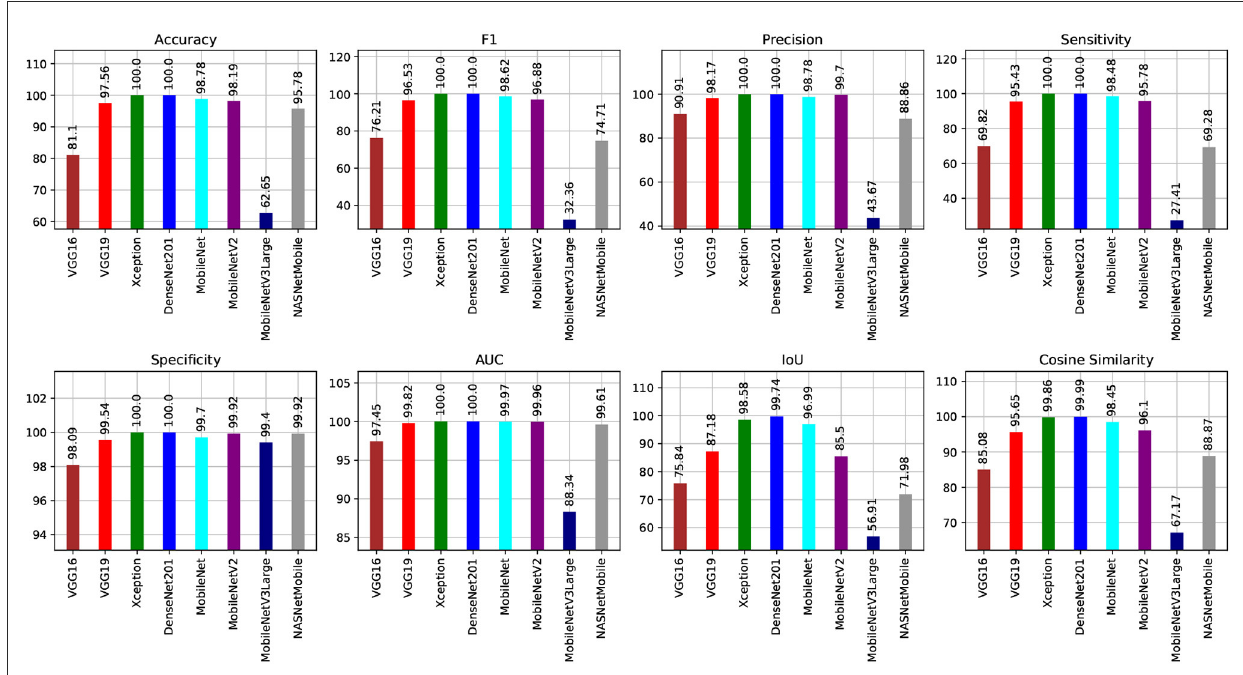
FIGURE9 Summarization of the learning and optimization experiments related to the Five-classes dataset.